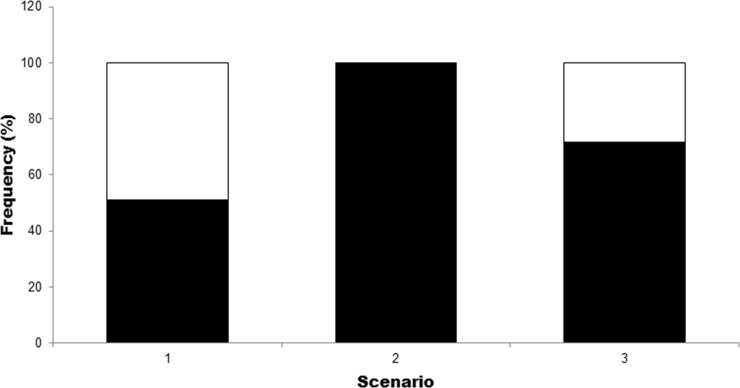
Proportions of finite rate of population growth (λ).Smaller values (black) and larger (white) than 1 of the 1000 simulations by scenario for Carcharhinus porosus.